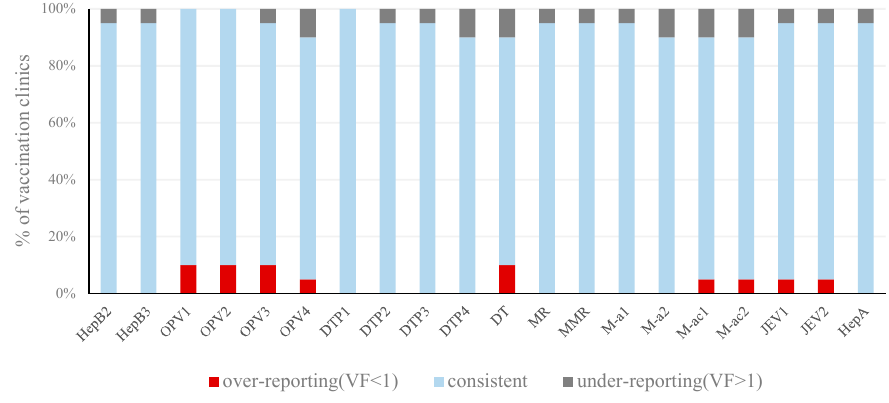
Figure 2. Distribution of vaccination clinics by VFs of the 20 vaccine doses in Shangyu District, 2014.